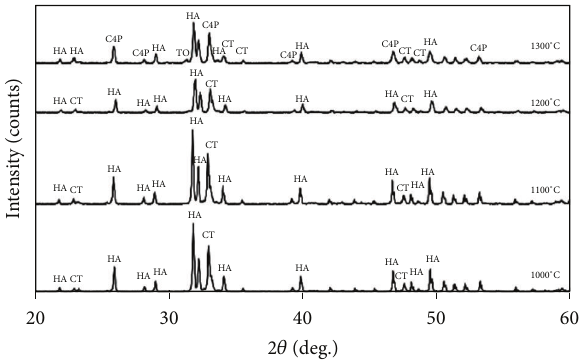
Figure 3: X-ray diffractograms of 10BHA composites sintered at different temperatures.